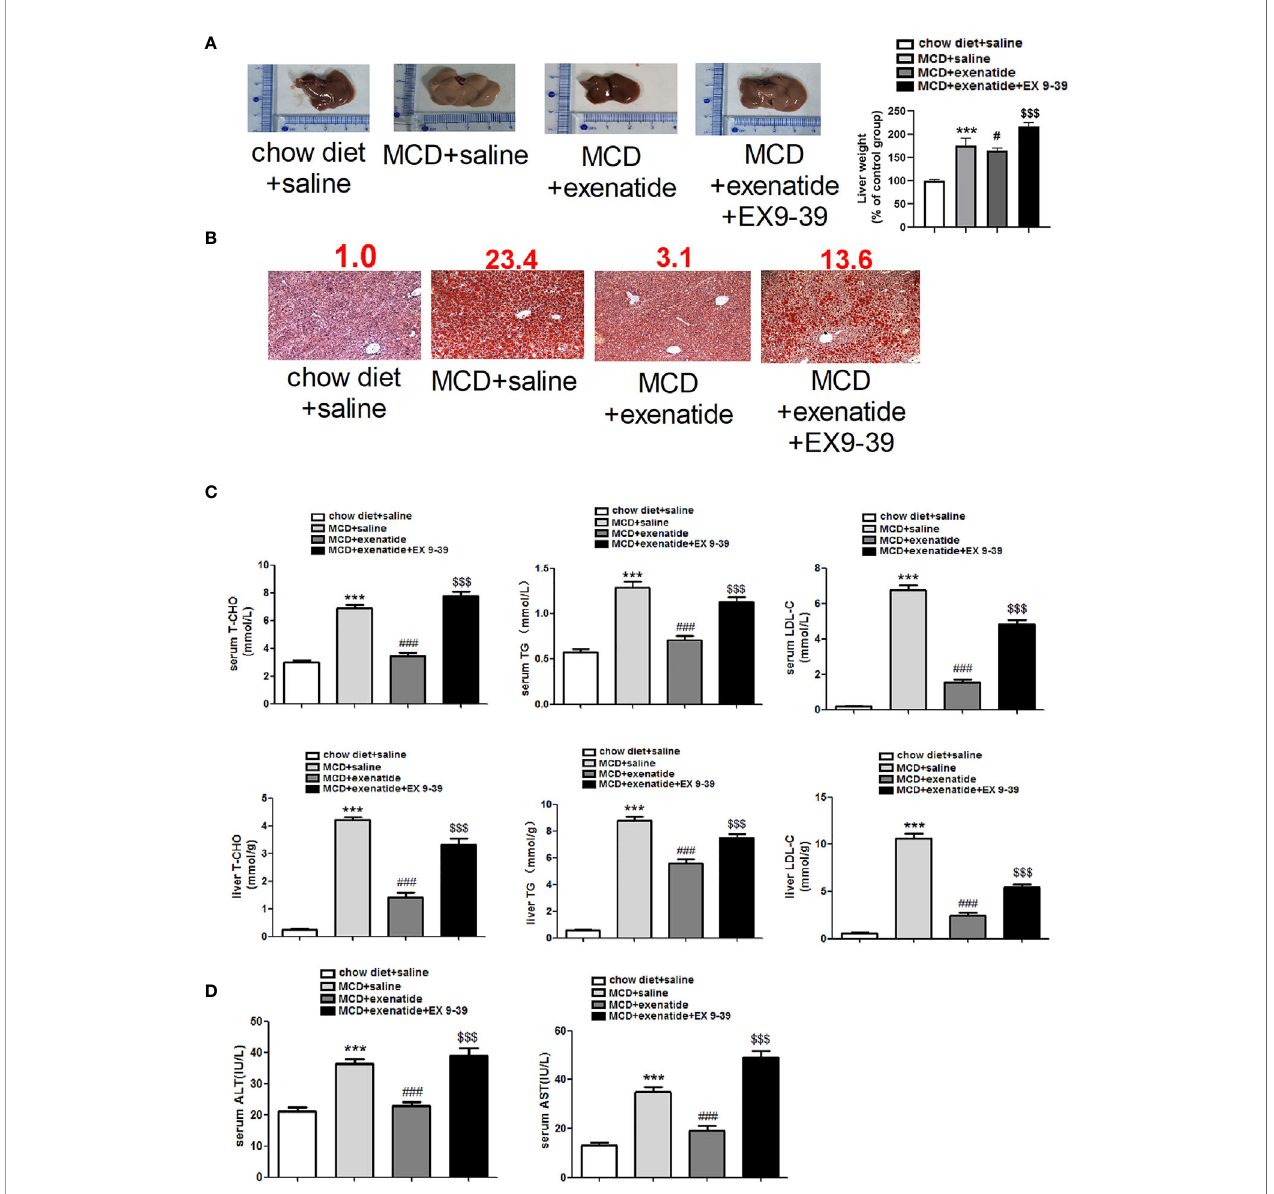
FIGURE 2 | Exenatide attenuated NASH in vivo . (A) Representative images of liver tissue and the semiquantitative analysis of liver weight. (B) Representative Oil Red O staining image. The numbers above each picture (shown in red) indicated the relative staining intensity as quanti fi ed by ImageJ. (C) Liver tissue and serum levels of T-CHO, TG, and LDL-C were measured to con fi rm the protective effect of exenatide in NASH. (D) The levels of serum ALT and AST. ***p < 0.001 vs. chow diet + saline; ### p < 0.001 vs. MCD + saline; $$$ p < 0.001 vs. MCD + exenatide (n = 5 – 6). Data are expressed as the mean ±